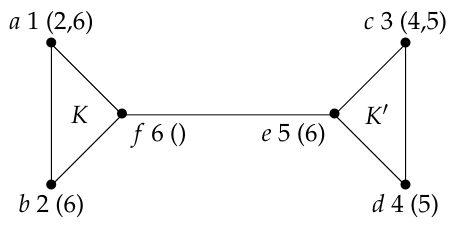
Figure 2. LexDFS labels do not detect new maximal